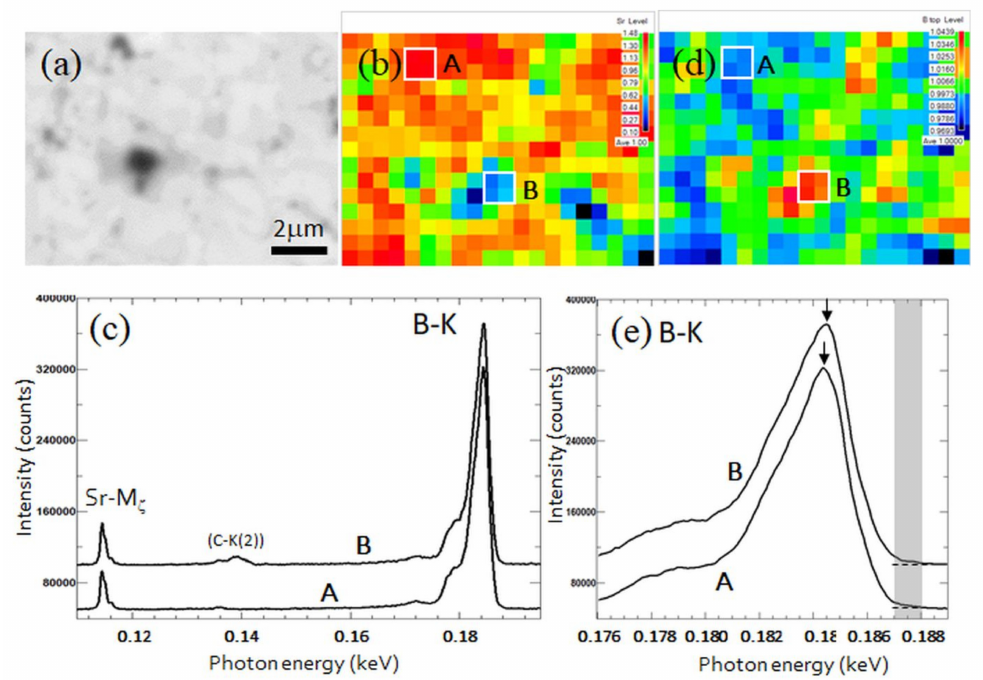
Figure 4. ( a ) BSI image, ( b ) Sr M ζ -emission intensity map, ( c ) spectra of areas A and B in ( b ), ( d ) chemical shift map of B K-emission, and ( e ) B K-emission spectra of A and B in ( d